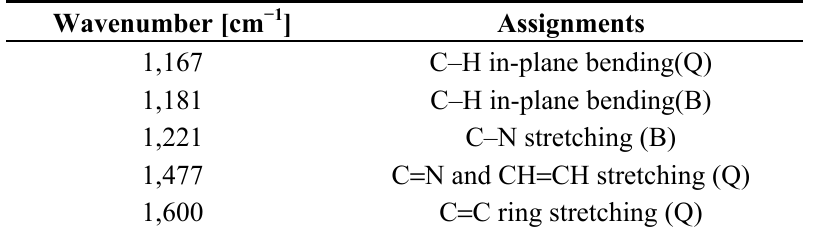
Table 1. Assignments of the Raman bands with 514 nm excitation